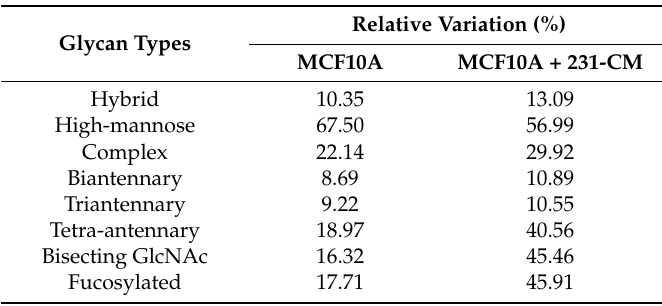
Relative variation of various types of N -glycans in DMEM/1% FBS-incubated and 231-CM-treated MCF10A cells.